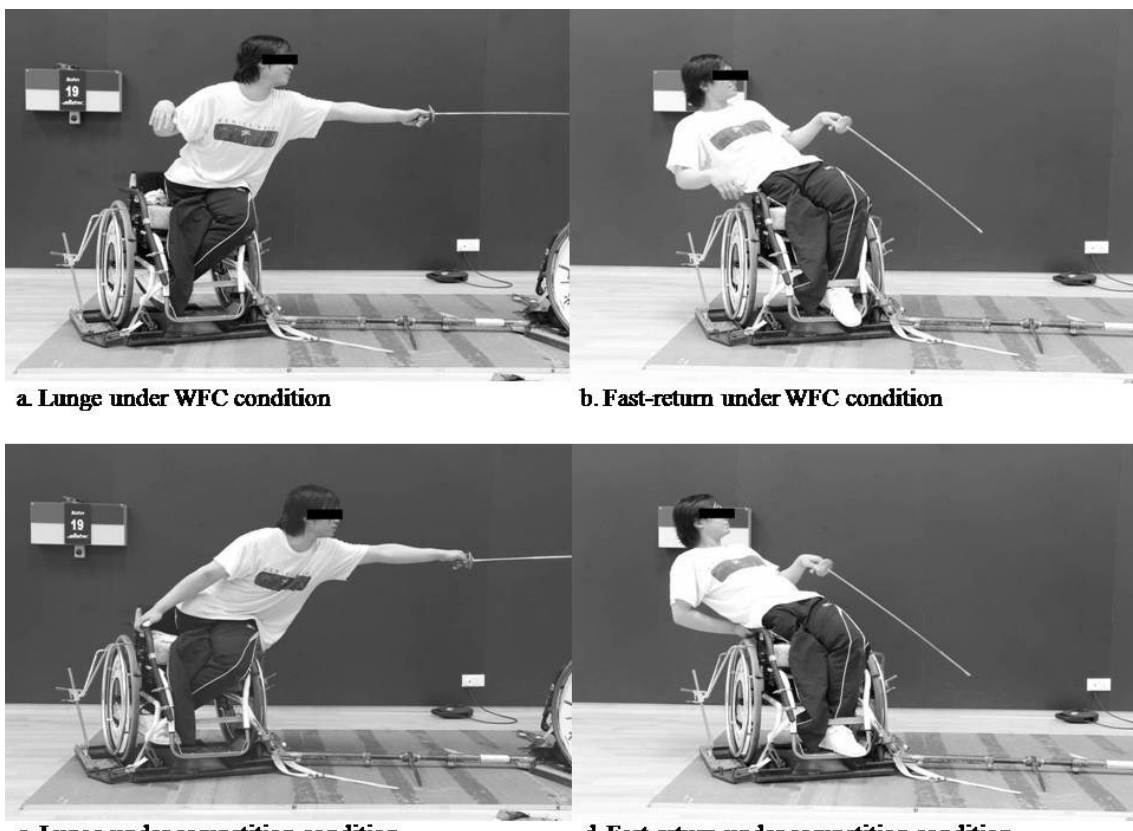
Distance normalization between experimenter and participant.